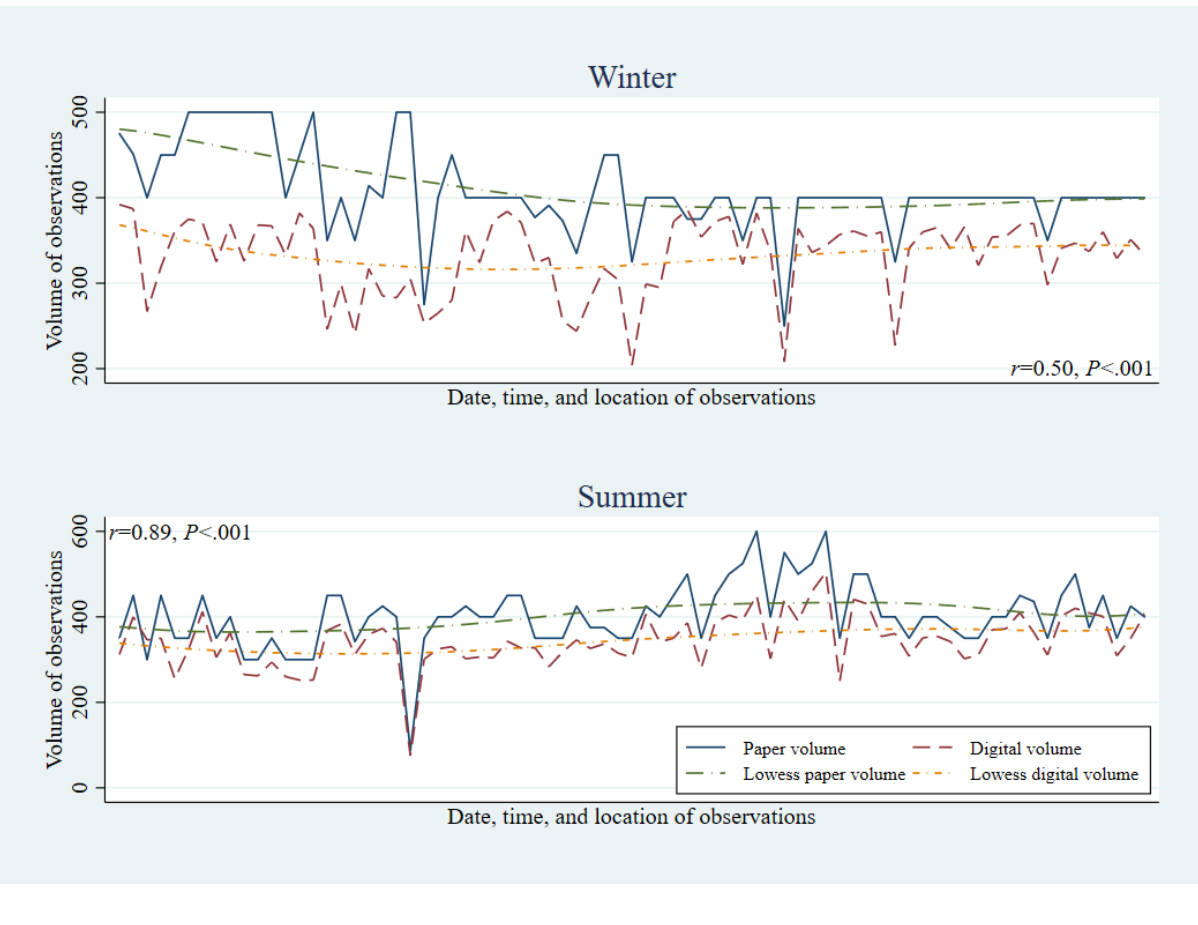
Figure 3. Speeding: correlation between digital and paper volumes of observations by round.